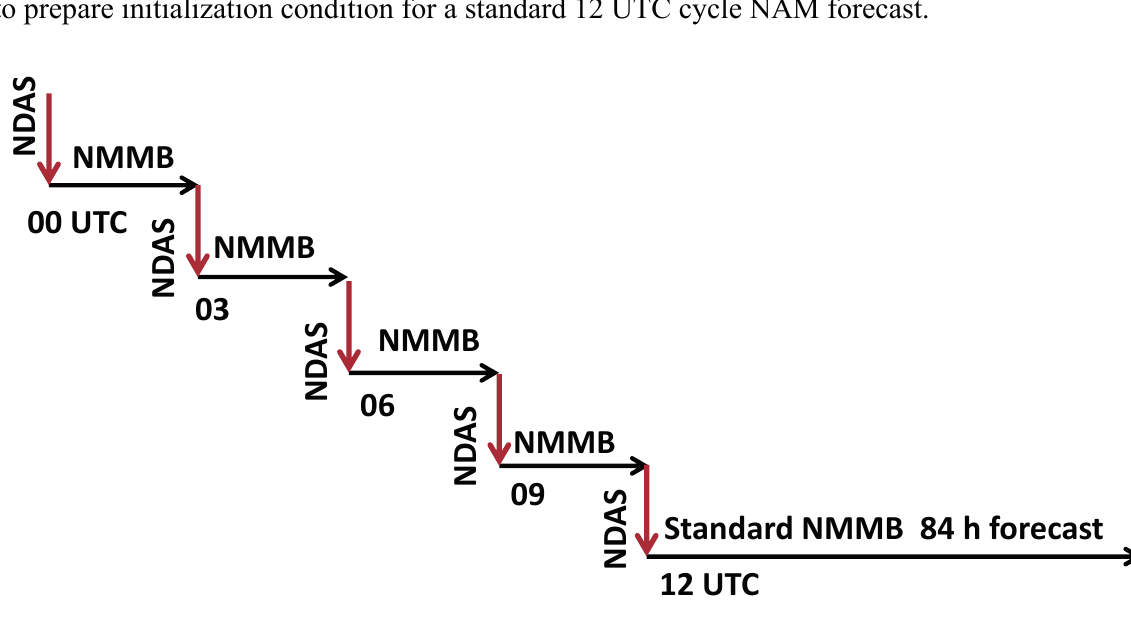
Figure 2. Schematic diagram of four sequences of the NDAS and NMMB short forecasts to prepare initialization condition for a standard 12 UTC cycle NAM